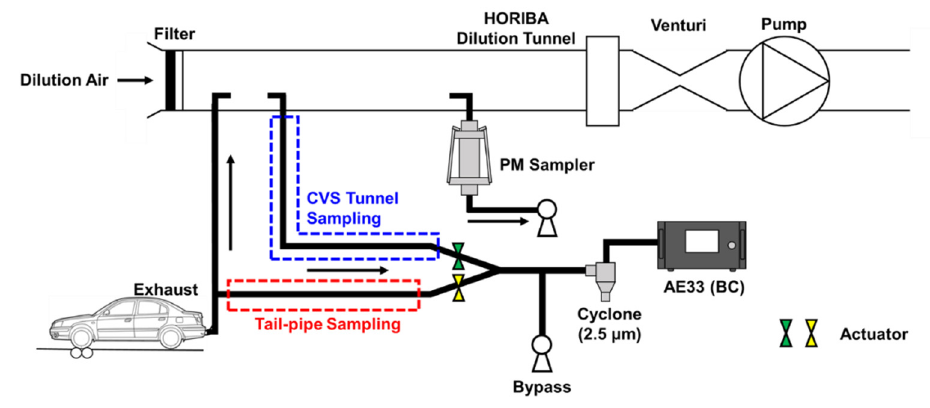
Figure 3. Sampling system of measuring black carbon. Only one sampling line was opened for one measurement. CVS tunnel sampling for CVS-75 and NEDC modes; Tail-pipe sampling for NIER modes.